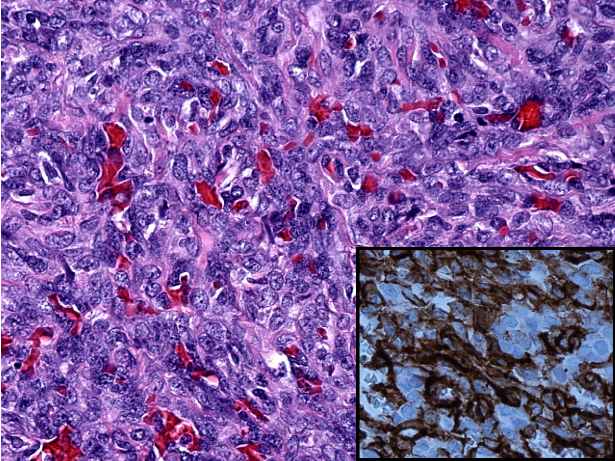
Figure 3: Microscopic examination revealing more solid areas with increased cellularity and compact vascular channels intervening be- tween sheets of spindle cells. No residual testicular parenchyma is present. The inset shows immunohistochemical analysis with tumor cells reacting strongly for CD 31 (PECAM-1) membrane